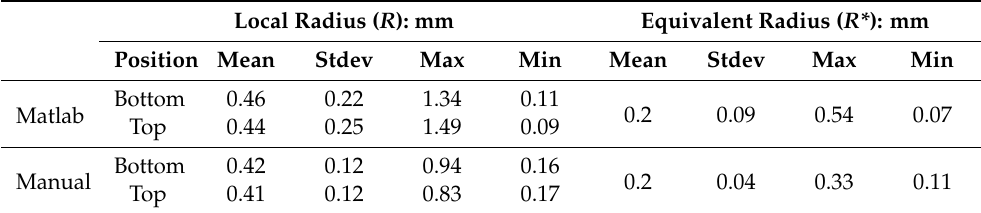
Table 2. Summary of test results in terms of local radius and equivalent radius computation based on Matlab and manual analysis of local morphology.